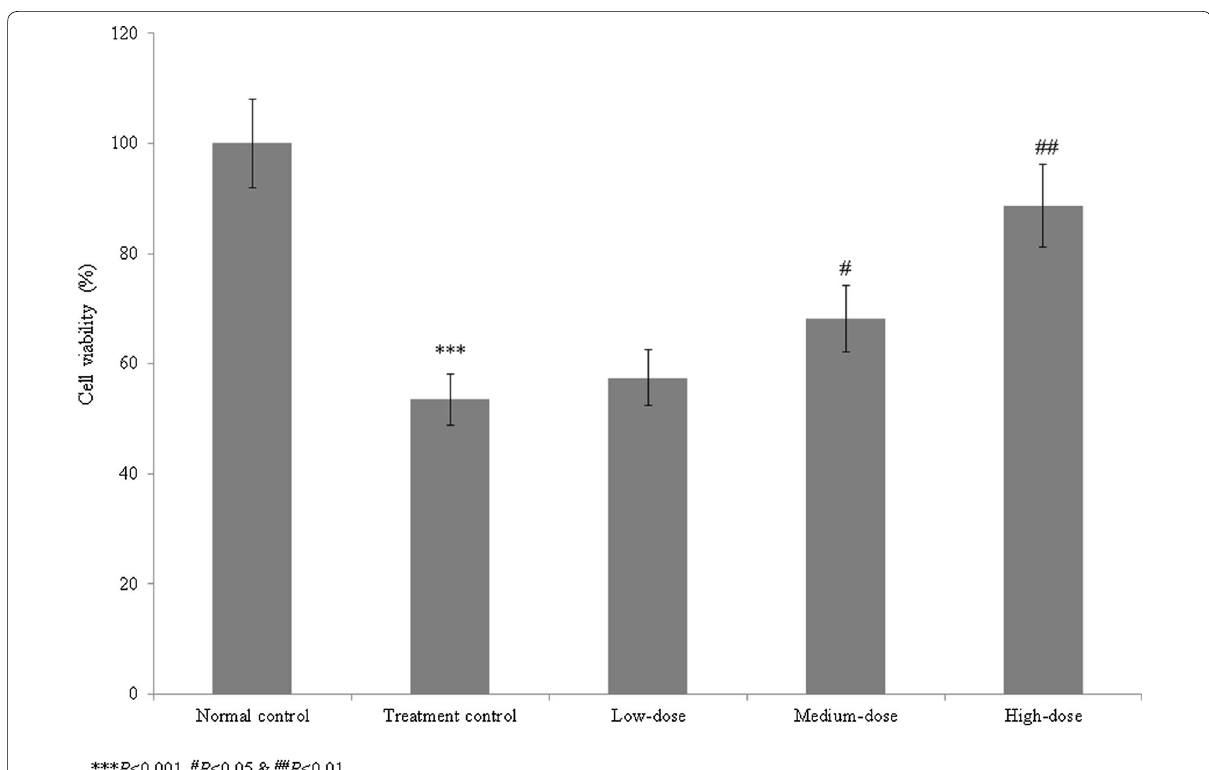
Fig. 1 Effect of catalpol on the viability of human induced pluripotent stem cells with aconitine-induced cardiac arrhythmia. Catalpol supplementation increased cell viability by 7.5, 27.3, and 65.8% at 1, 10, and 100 µM concentrations, respectively. *** P < 0.001 vs. Group I; # P < 0.05 and ## P < 0.01 vs. Group